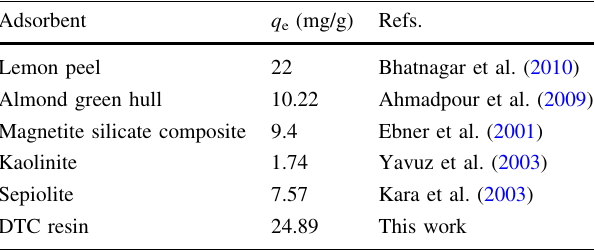
Table 1 The maximum adsorption capacity of Co(II) ion in different adsorbents